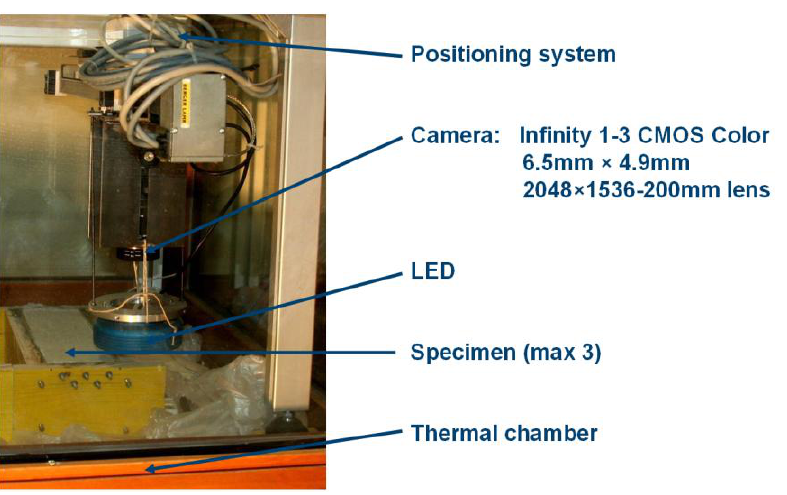
Figure 1. The developed system for crack aperture